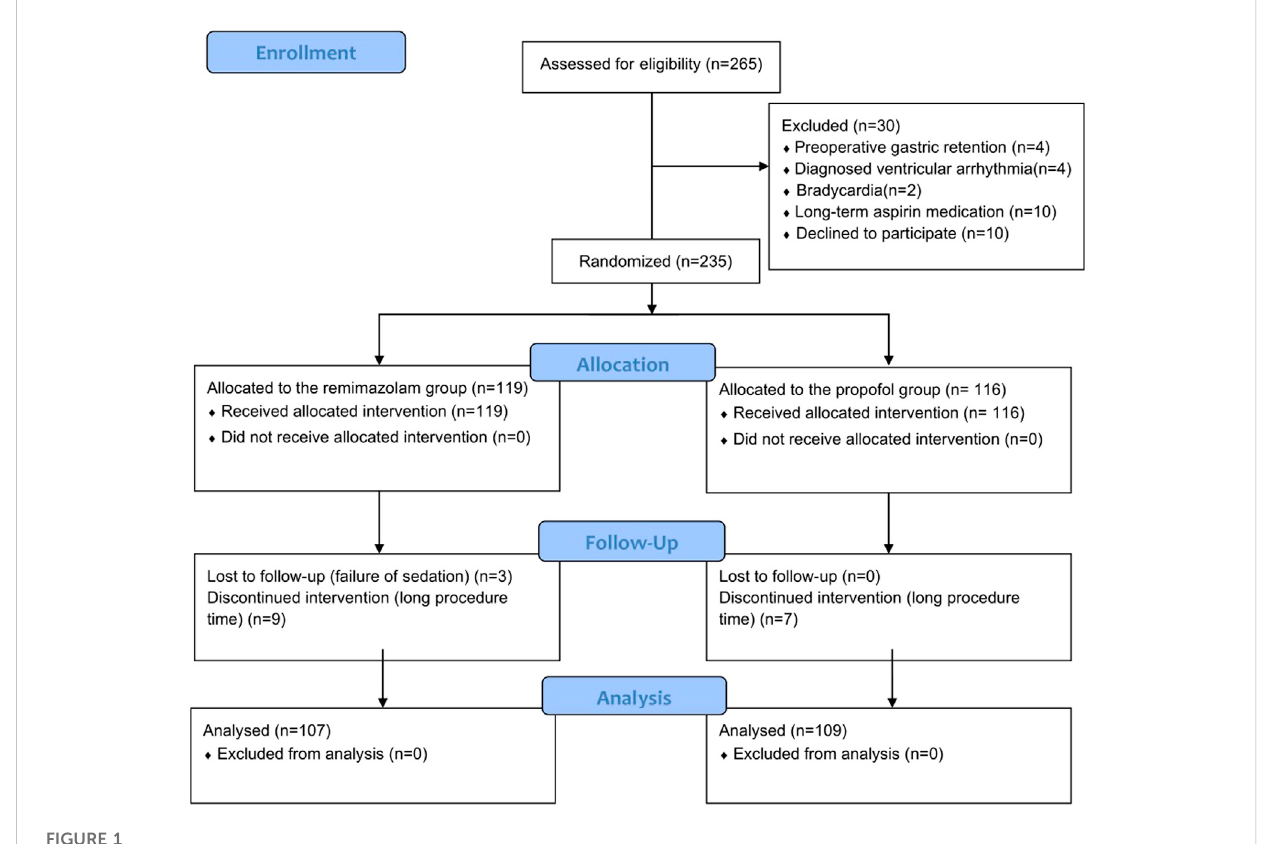
FIGURE 1 Patient fl